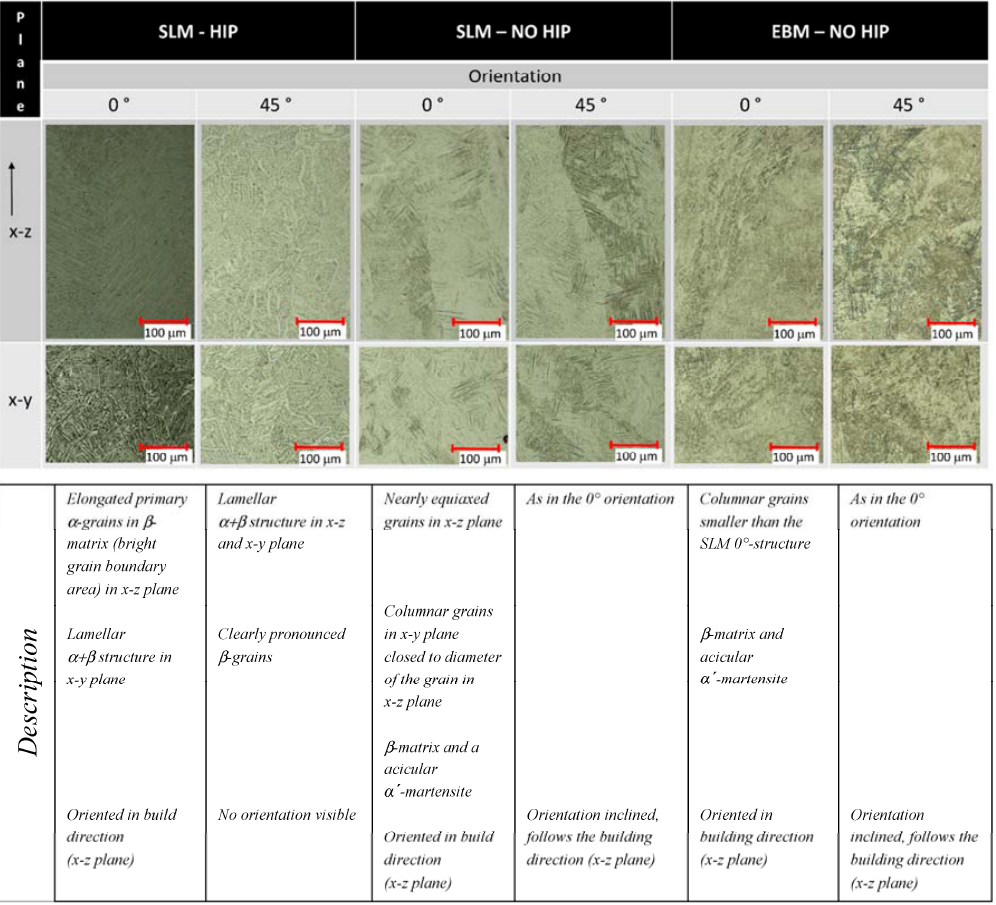
Figure 14. Overview about the microstructure of all manufactured parts in relation to the building orientation (0° and 45°) as well as to post ‐ treatment conditions (heat treatment—HIP—hot isostatic pressing or No HIP). The arrow shows the building direction.